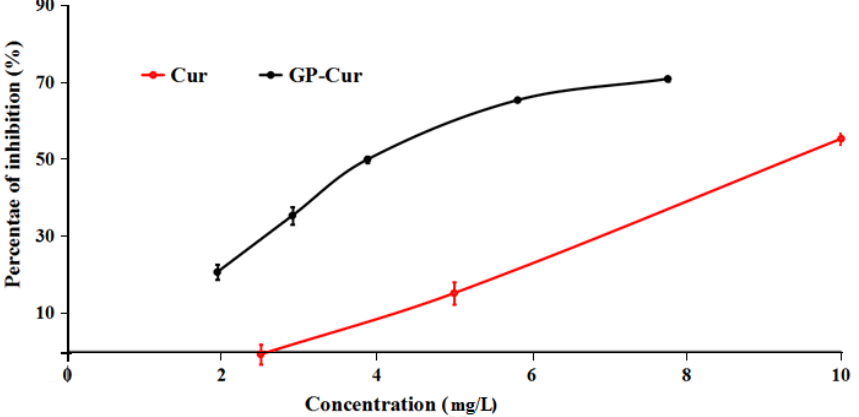
Figure 9. Cytotoxicity behavior of free Cur- and nCur-encapsulated GP-F127 samples on the inhibition of cancer cells growth.